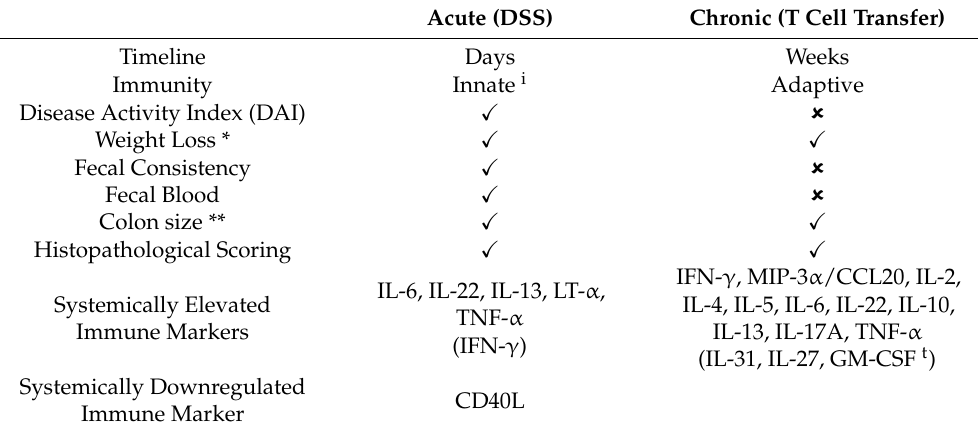
Table 3. Phenotypes of acute (DSS-mediated) and chronic (T-cell-transfer-mediated) IBD models. Acute (DSS)